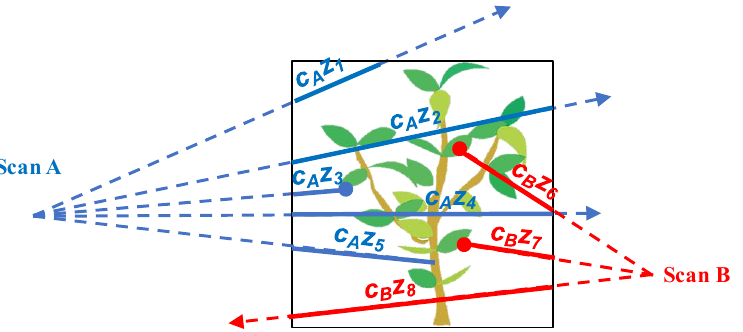
Figure 3. Scheme of the information provided by the traversal algorithm, which is used to compute the Maximum Likelihood Estimator (MLE) of the Leaf Area Density ( LAD ) from multiview data from Scan A (in red) and Scan B (in blue): leaf hits (blue and red dots) and free paths (distances z travelled by the beams; blue and red lines) in the voxel. The dotted lines represent pulse trajectories; c A = G A and c B = G B represent the correcting factors for viewpoints A and B, respectively, which di ff ers with H B distance to scanner and view angle. For simplicity, correction for e ff ective free path ( z e ; Equation (3)) is ignored. Note that in this framework, no leaf can be distributed within the volume V W occupied by wood elements (in brown). Also, and contrary to Figure 1, the hits corresponding to woody elements (e.g., 5th beam of scan 1) are ignored in the hit sum, but the corresponding free paths are accounted for in the free-path sum, in which c A and c B are used as multiplicative factors. As for a single viewpoint, this “MLE” is biased when the number of beams is low and a correction can be computed [15]. Generalizing this correction to the multiview LAD estimator (“ M ”) led to (Appendix B):